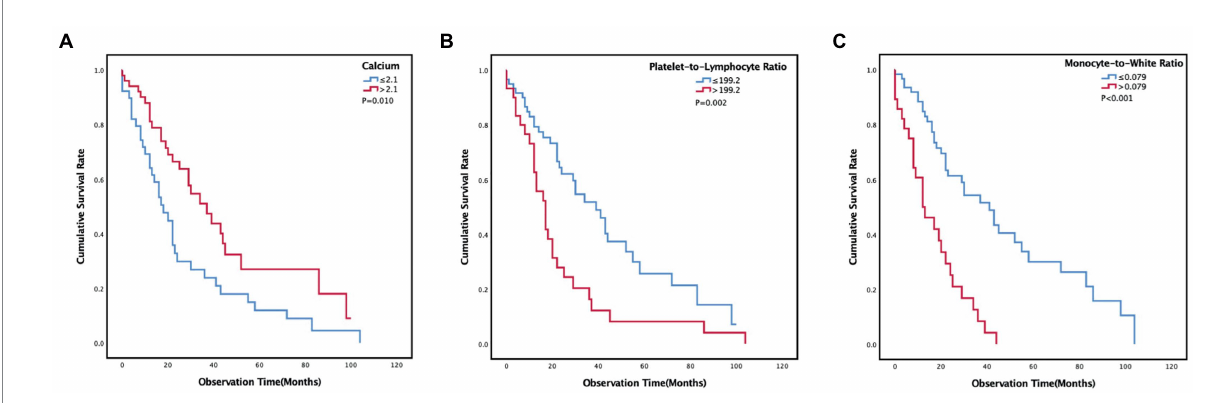
FIGURE 2 Kaplan–Meier curves estimates of prognosis in different calcium (A) , platelet-to-lymphocyte ratio (B) , monocyte-to-white ratio (C) groups of malignant pleural mesothelioma